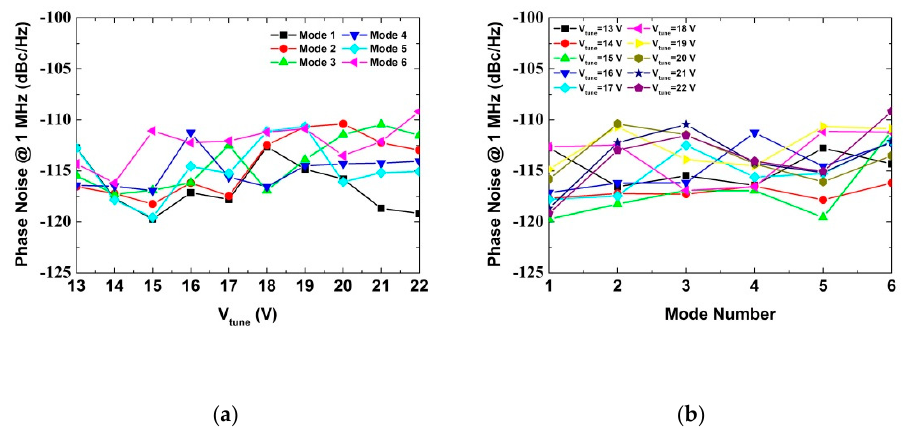
Figure 7. Measured phase noise versus ( a ) varactor biases and ( b ) selection modes for the switched inductor VCO.